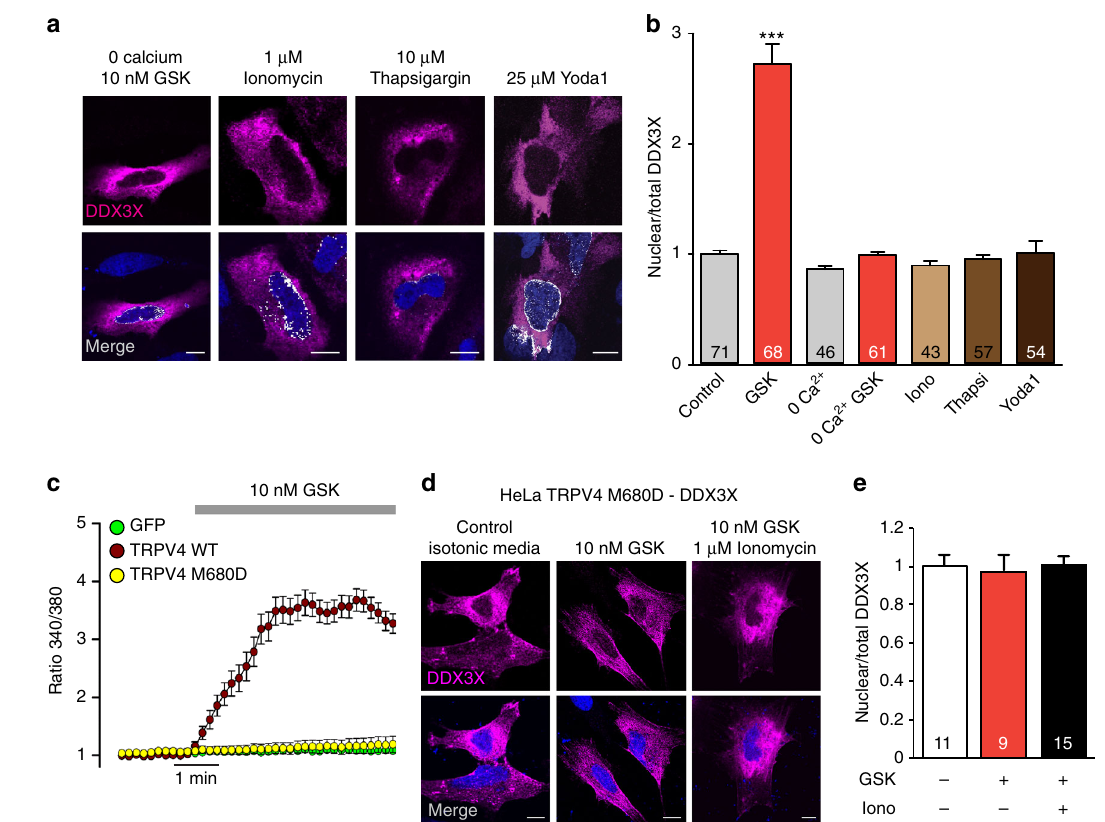
Fig. 3 TRPV4-mediated Ca 2 + in fl ux triggers DDX3X nuclear shuttling. a Confocal immuno fl uorescence images of DDX3X (magenta) in HeLa cells overexpressing TRPV4-V5 and DDX3X-Myc. Nuclei were stained with DAPI (blue). Colocalization of DDX3X and nuclei is shown in white in the merge panels. b Mean nuclear/total DDX3X ratio determined under the experimental conditions indicated. c Mean± SEM of intracellular Ca 2 + signals (Fura-2 ratio) obtained in HeLa cells transfected with GFP ( n = 41), TRPV4-WT ( n = 53) or TRPV4-M680D ( n = 62), and stimulated with 10 nM GSK1016790A. d Confocal immuno fl uorescence images of DDX3X (magenta) in HeLa cells overexpressing TRPV4-M680D and DDX3X-Myc. Nuclei were stained with DAPI (blue). Colocalization of DDX3X and nuclei is shown in white in the merge panels. e Mean nuclear/total DDX3X ratio determined under the experimental conditions indicated. The number of cells analyzed for each condition is indicated in each bar. The data are means ± SEM. *** P < 0.001 when comparing isotonic control with any other condition as determined by non-parametric Krustal – Wallis followed by Dunn ’ s post hoc test ( b , e ). Scale